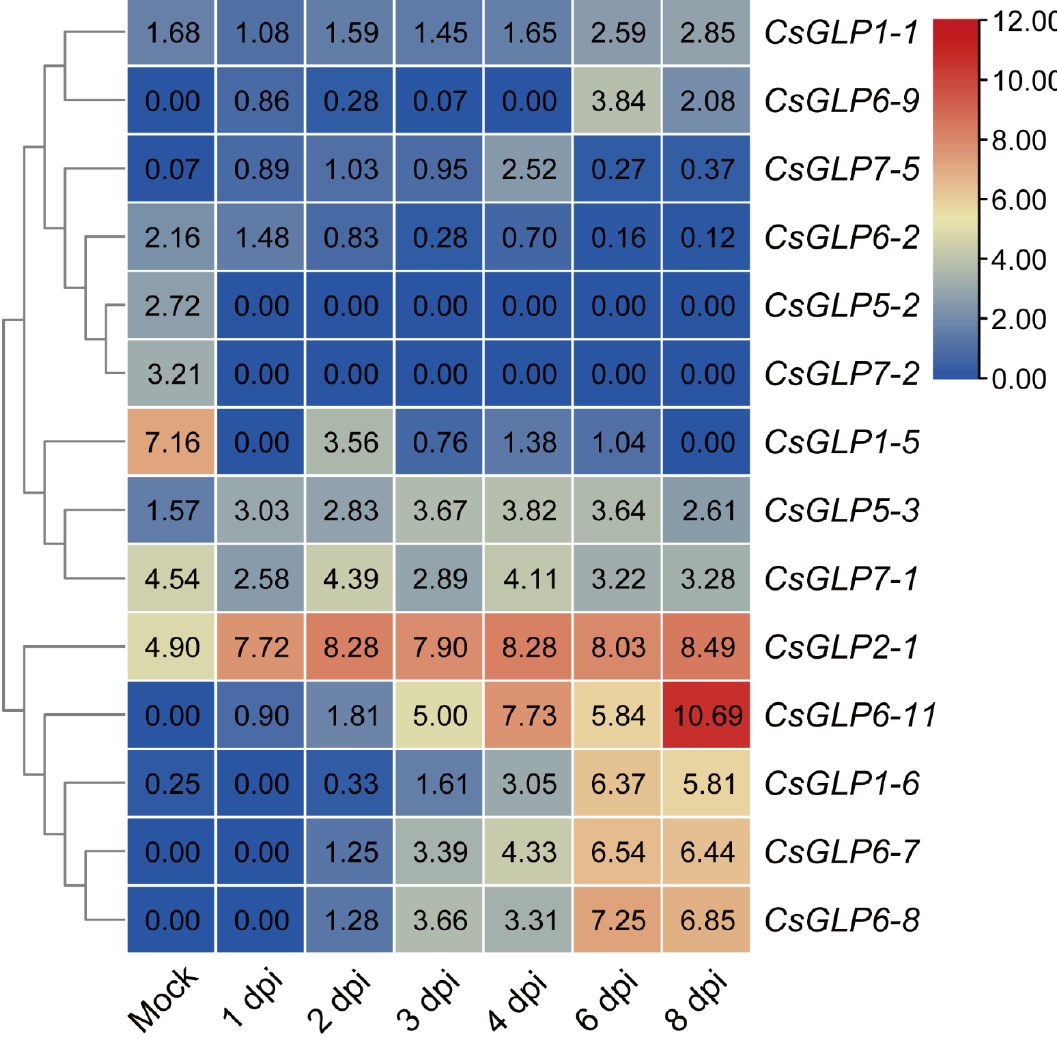
Figure 6. Expression patterns of CsGLP genes in response to inoculation with downy mildew for 1 to 8 days post inoculation (dpi). Mock, mock-inoculated sample collected at 1 dpi.